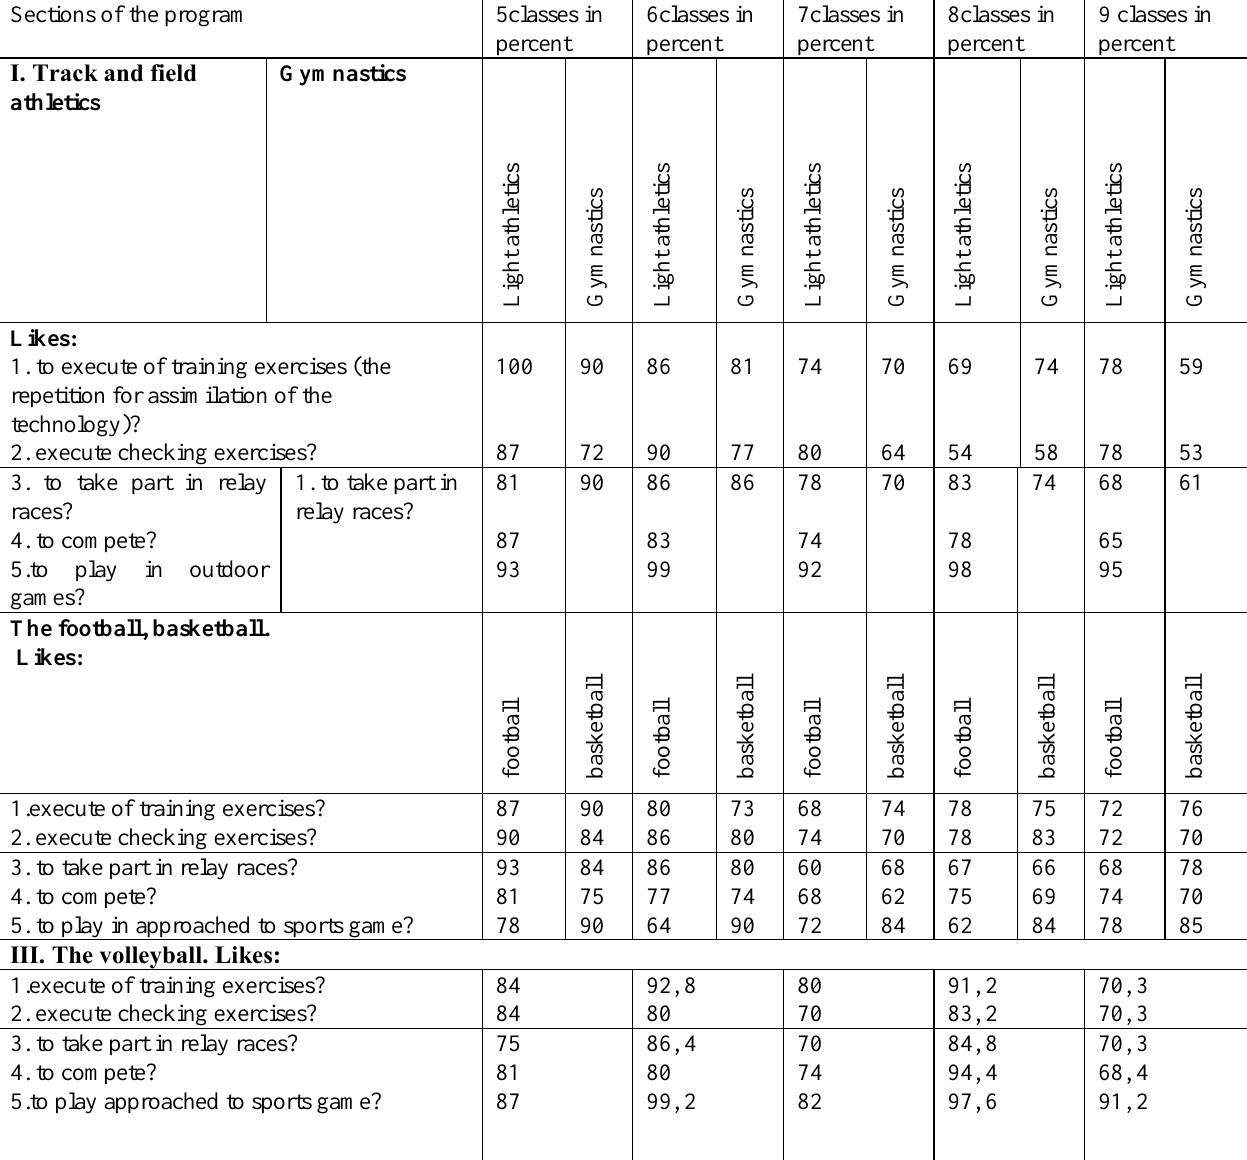
Indicators of the relation of pupils of middle classes to training methods in